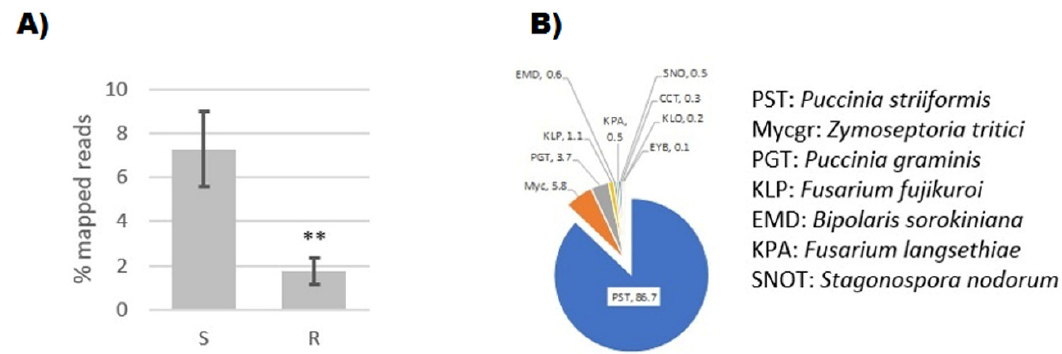
Figure 7. Metagenomic analysis of the selected wheat pathogens: ( A ) the percentage of pathogen reads that are mapped to each species (*** p < 0.001; ** p < 0.01); ( B ) the mapping percentage of reads for the pathogenic fungal genome.